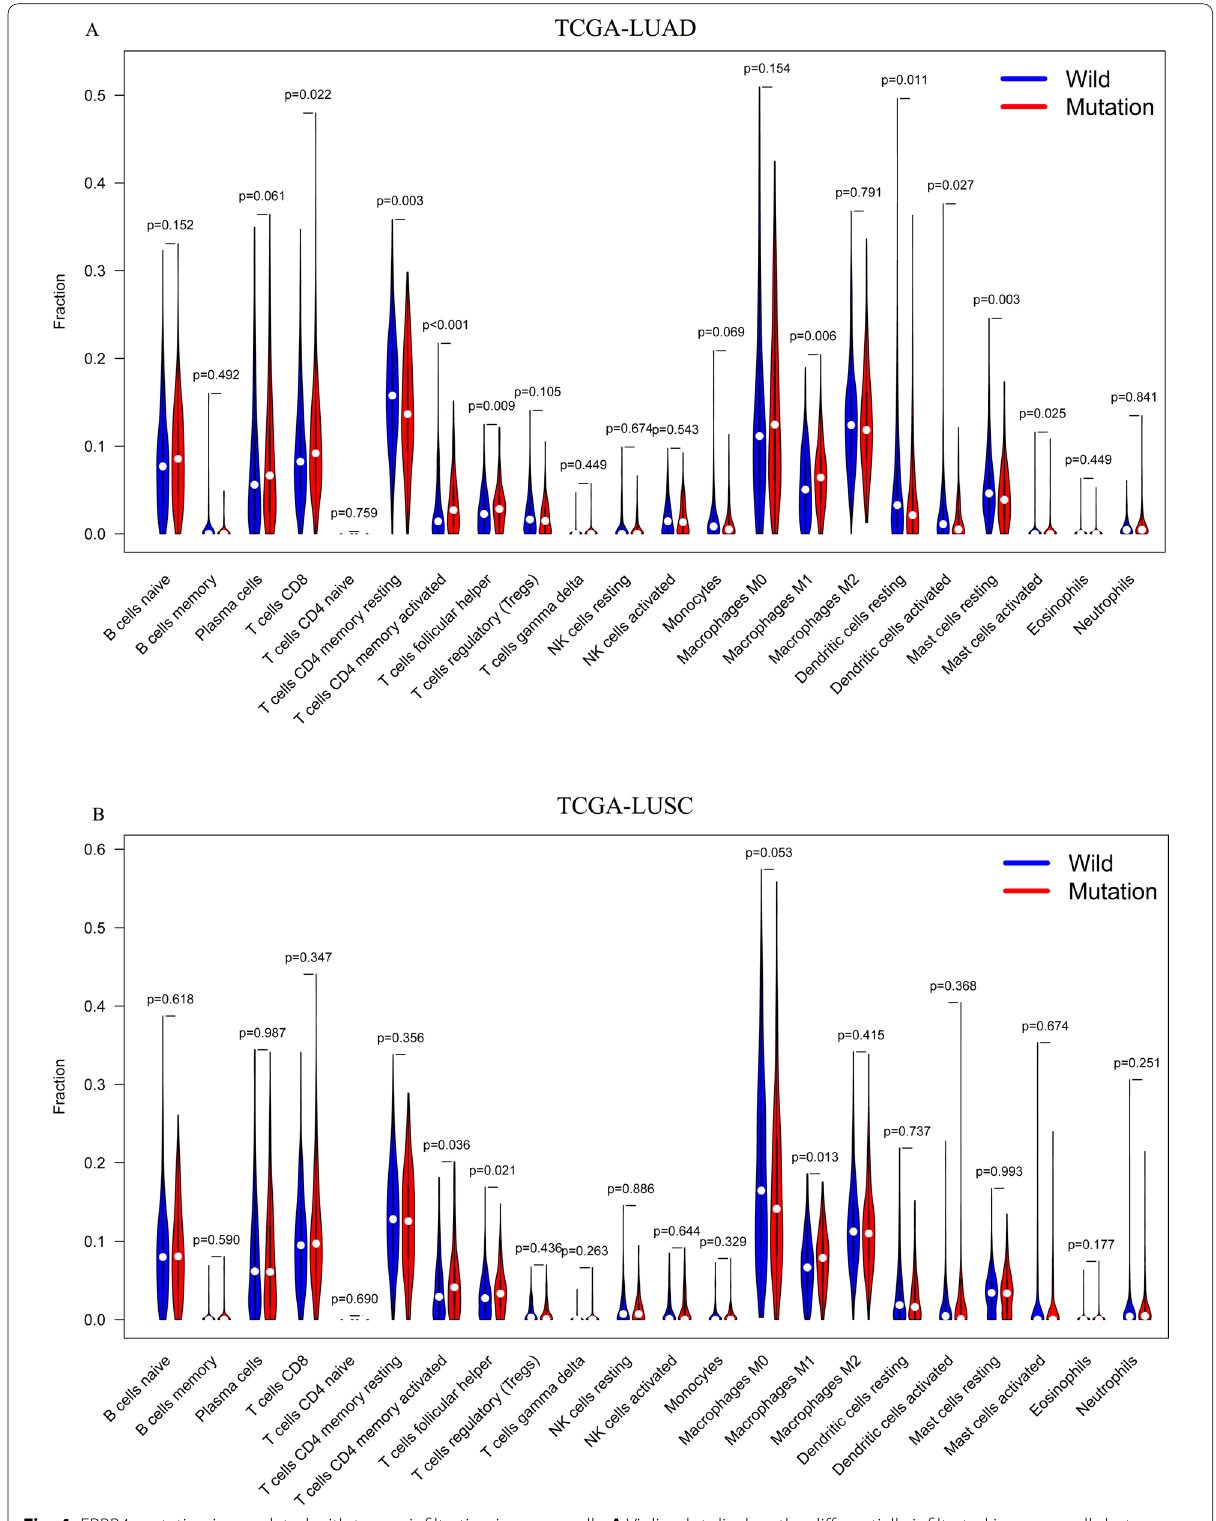
Fig. 4 ERBB4 mutation is correlated with tumor-infiltrating immune cells. A Violin plot displays the differentially infiltrated immune cells between ERBB4-mutant groups and ERBB4-wild group in LUAD-TCGA cohort. B Violin plot displays the differentially infiltrated immune cells between ERBB4-mutant groups and ERBB4-wild group in LUSC-TCGA